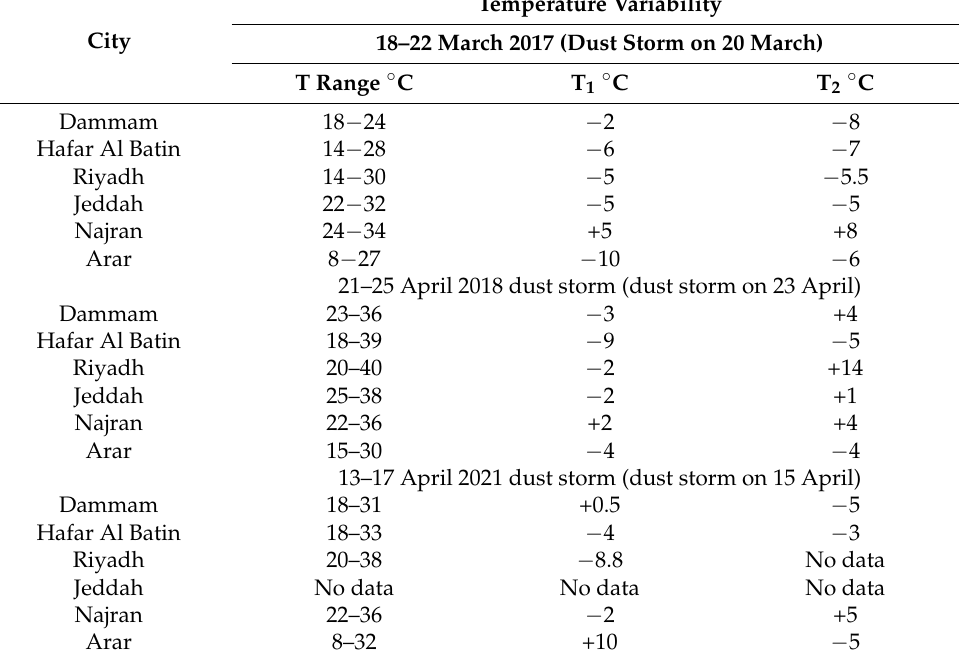
Table 3. Temperature variability during the 20 March 2017, 23 April 2018, and 15 April 2021 dust events. T 1 = temperature (day of the storm) − temperature (two days before the storm) and T 2 = temperature (day of the storm) − temperature (two days after the storm). T 1 and T 2 were measured at 13:12 local